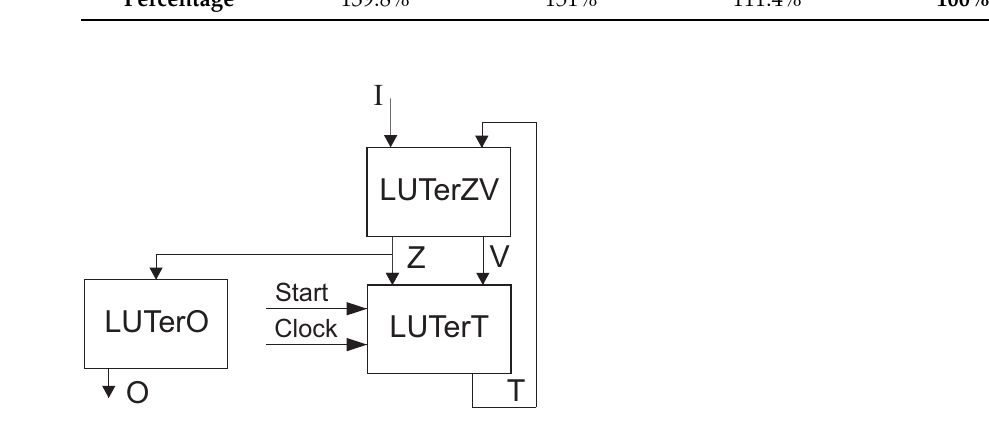
Figure 28. Structural diagram of P o Y Mealy